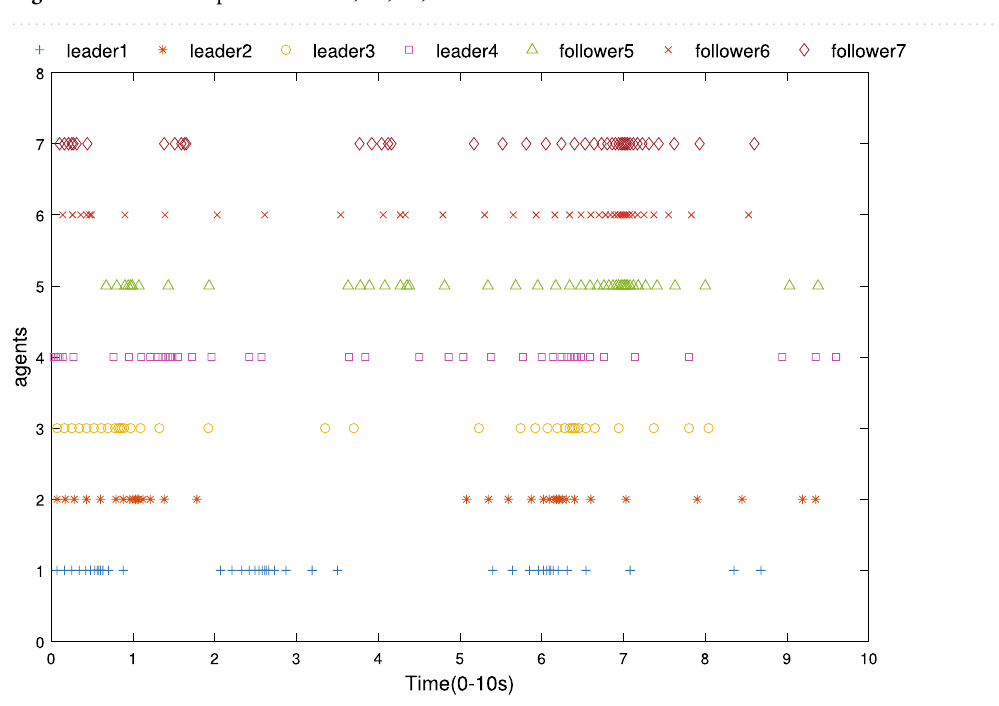
Figure 6. Events triggering times of